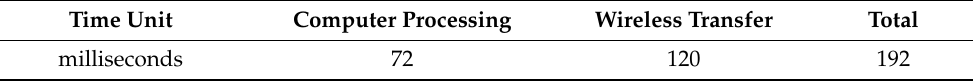
Table 6. Real-time performance (Latency).